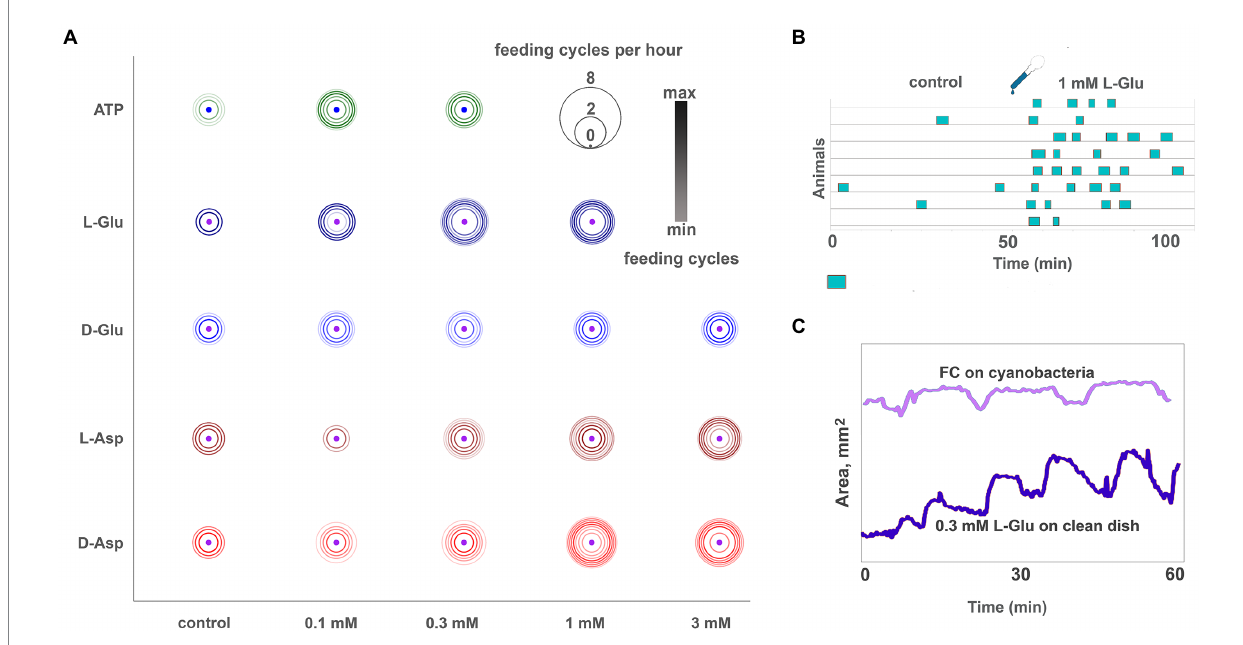
FIGURE 4 Glutamate, aspartate, and ATP induce reactions similar to feeding cycles on algal biofilm. (A) Bubble plot comparison of various ATP, L- and D-glutamate concentrations and L- and D-aspartate in inducing feeding-like cycles. Pharmacological activity decreases in the following order: L-Glu > D-Asp > L-Asp > D-Glu. Unlike other tested amino acids, the D-Glu response is not dose-dependent (the difference between adjacent concentrations is insignificant). Feeding cycles for 3 mM L-Glu are not shown because this concentration elicits prolonged (30–90 min) arrest of locomotion and nearly permanent body expansion instead of regular 5–10 min feeding cycles (see Supplementary Video S8). Scale: feeding cycles per hour, the color bar was normalized: black—max counts, light grey—min counts. (B) Diagram of feeding-like activity of Trichoplax adhaerens on the clean glass dish. In control, only a few occasional cycles are observed. After adding 1 mM L-glutamate, Trichoplax exhibit repeated feeding cycles similar but not identical to those observed on natural food substrates. (C) The plot of body area for representative animals feeding on cyanobacteria (light blue line) and clean glass upon addition of 0.3 mM L-Glu (dark blue line). Feeding-like cycles induced by L-Glu are shorter than natural feeding cycles (7– 10 min vs. 10–20 min), lack a ‘digestion phase’ with churning movements (plateau on the area plot), and have a more extended body contraction phase. In glutamate-induced feeding-like cycles, body contraction is often incomplete, and body area increases over consecutive